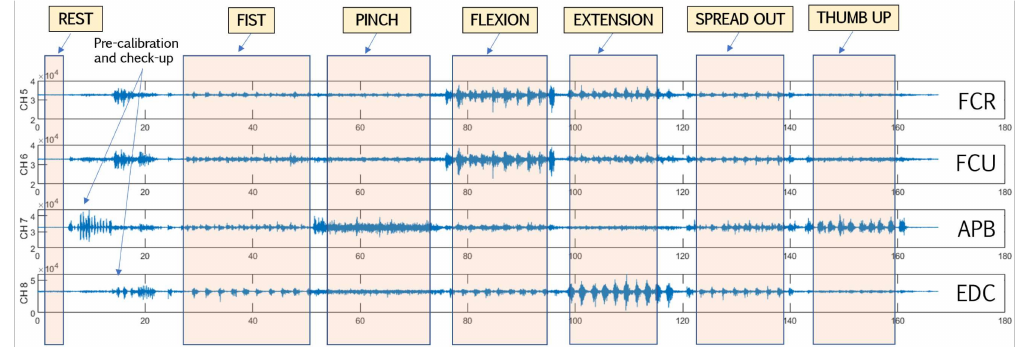
Figure 2. Representative four-channel sEMG data labeling and segmentation. FCR: flexor carpi radialis; FCU: flexor carpi ulnaris; APB: abductor pollicis brevis (thenar area); EDC: extensor digito- rum